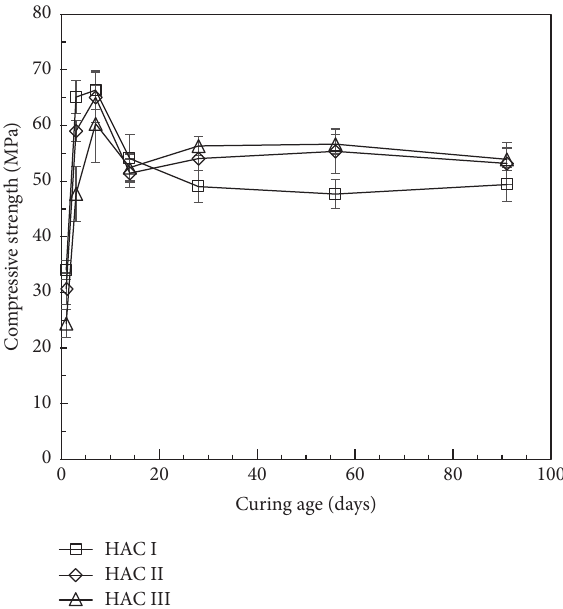
Figure 2: Development of compressive strength of mortar for different HAC types with curing